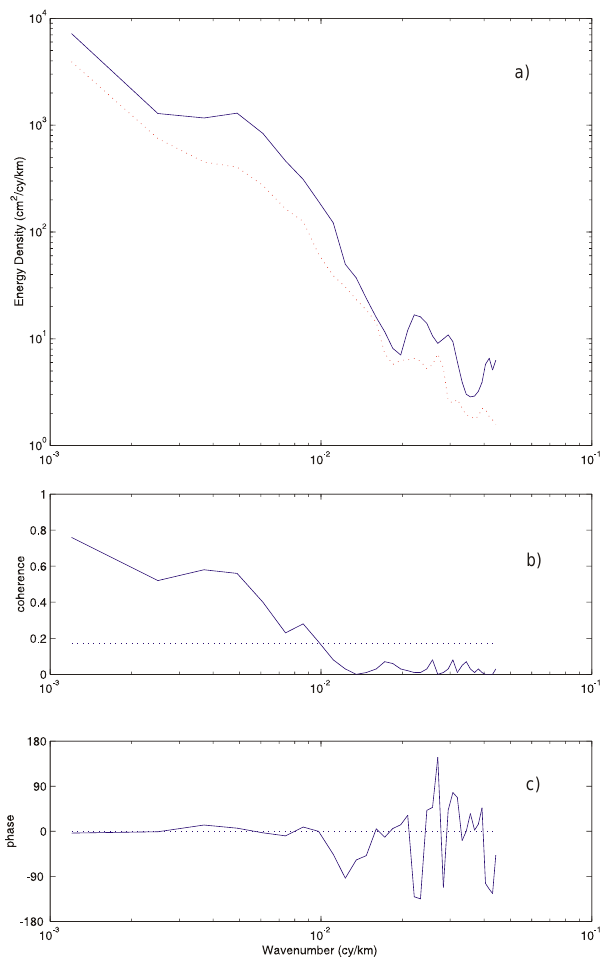
Fig. 8. (a) Spectra of steric heights (red line) and T/P altimetric heights (blue line). (b) Coherence amplitude. (c) Phase between steric and altimetric heights (positive phase indicates steric height